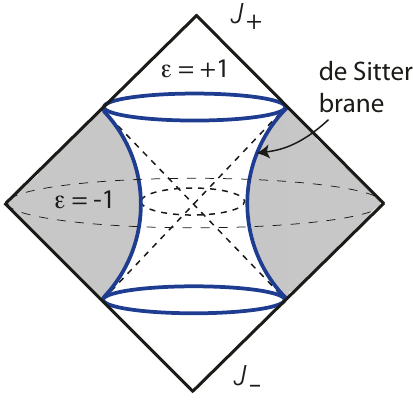
Figure 1 . dS brane in (cid:13)at bulk. We pick the unshaded interior when "H > 0, and the shaded exterior when "H < 0. These choices de(cid:12)ne two di(cid:11)erent branches of solutions. sets the numerical value of the graviton mass. Since the normal to the brane in any of the cases is @ as can be checked from the embedding map (3.1), using (2.17) for (cid:6) we w